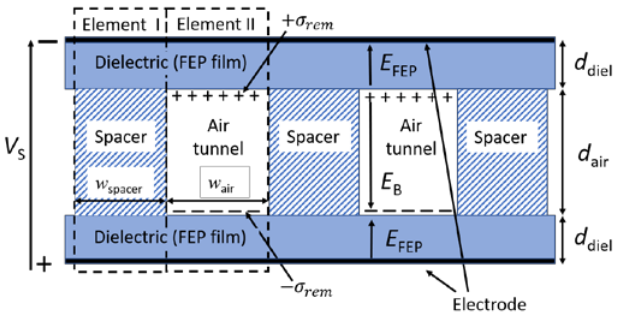
Figure 1. Schematic cross-section of a generalized structure of a ferroelectret.